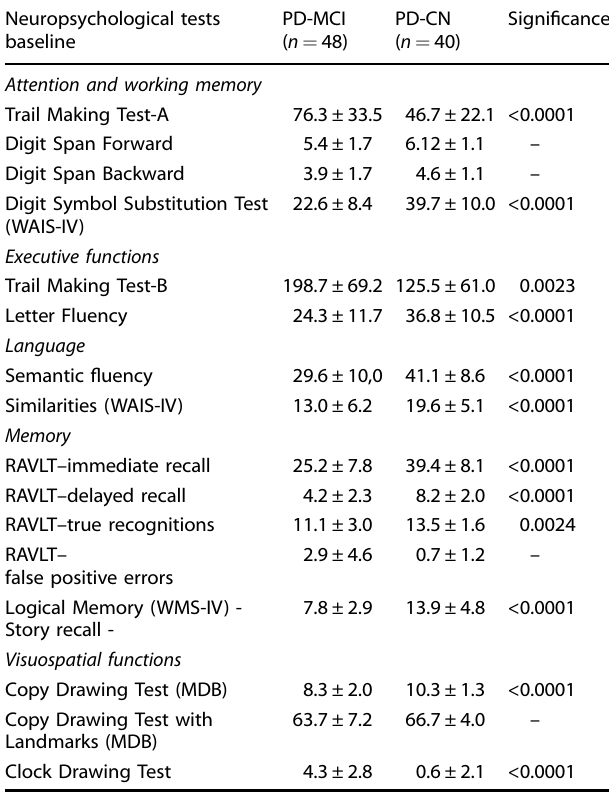
Table 2. Baseline cognitive scores at neuropsychological tests in PD- MCI and PD-CN groups.